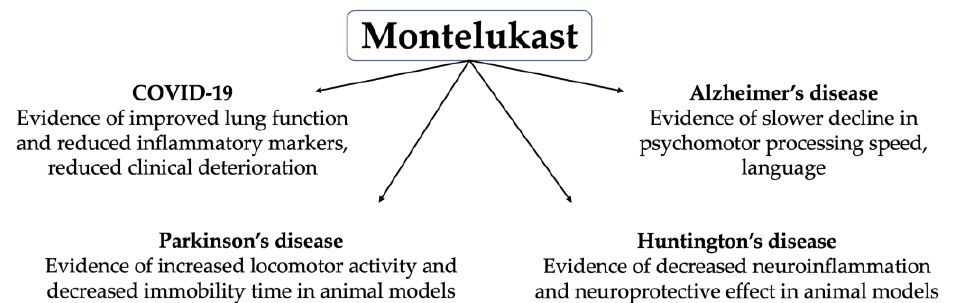
Figure 1. Not-asthma conditions with potential clinical applications of montelukast [17,18,24,26,28].